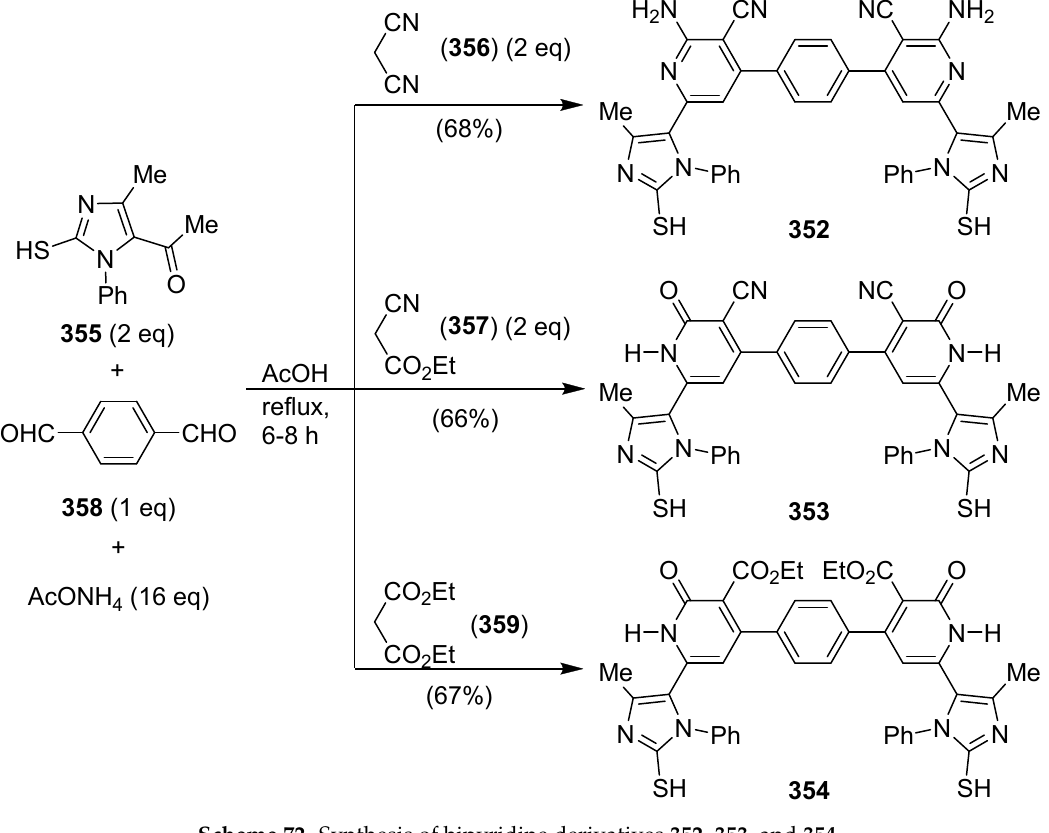
Scheme 72. Synthesis of bipyridine derivatives 352 , 353, and